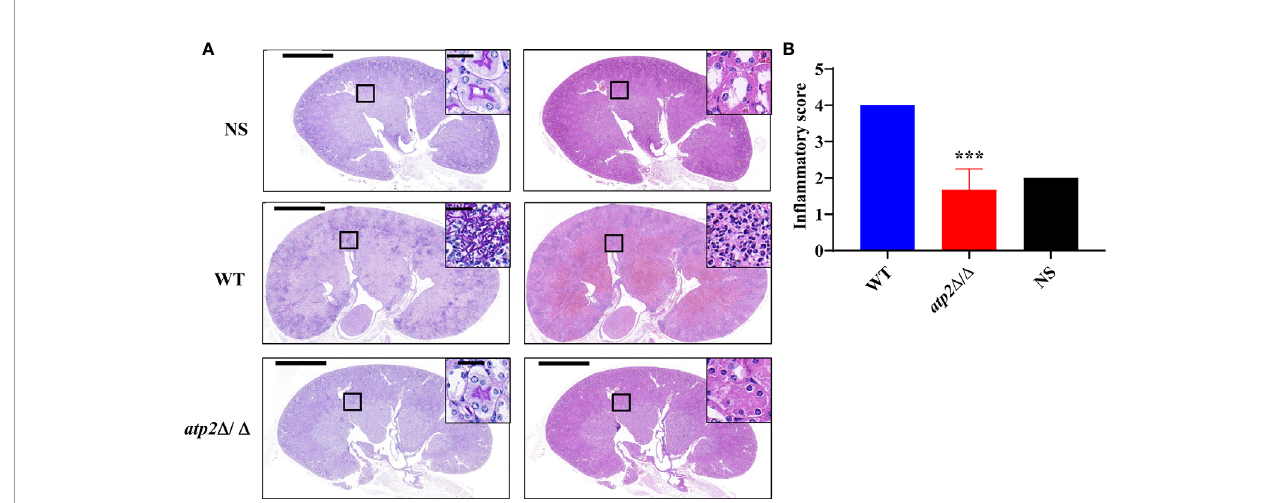
FIGURE 4 | C. albicans cells lacking ATP2 do not cause abnormal phagocytes in fi ltration in the kidney. (A) Representative images of Periodic acid-Schiff-stained (PAS) and Hematoxylin-Eosin-stained (HE) kidney sections of mice ( n = 3) 72 h after systemic infection with NS, WT or atp2 D / D (2 × 10 5 CFU per mouse). (B) In fl ammatory score based on renal immune cell in fi ltration and tissue destruction. In (A) , one representative experiment of three mice is shown. In (B) data are shown as mean ± s.d. *** P <0.001; by Student ’ s t -test. In (A) , insets show higher-magni fi cation images of boxed areas; scale bars, 1,000 µm, 50 µm (insets).